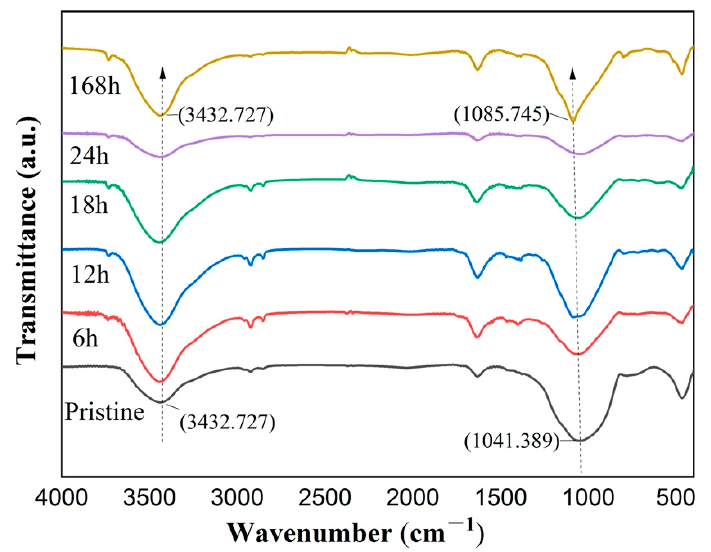
Figure 5. Fourier transform infrared (FT-IR) spectra of basalt fibers after being immersed in seawater solution at 85 °C for different times.